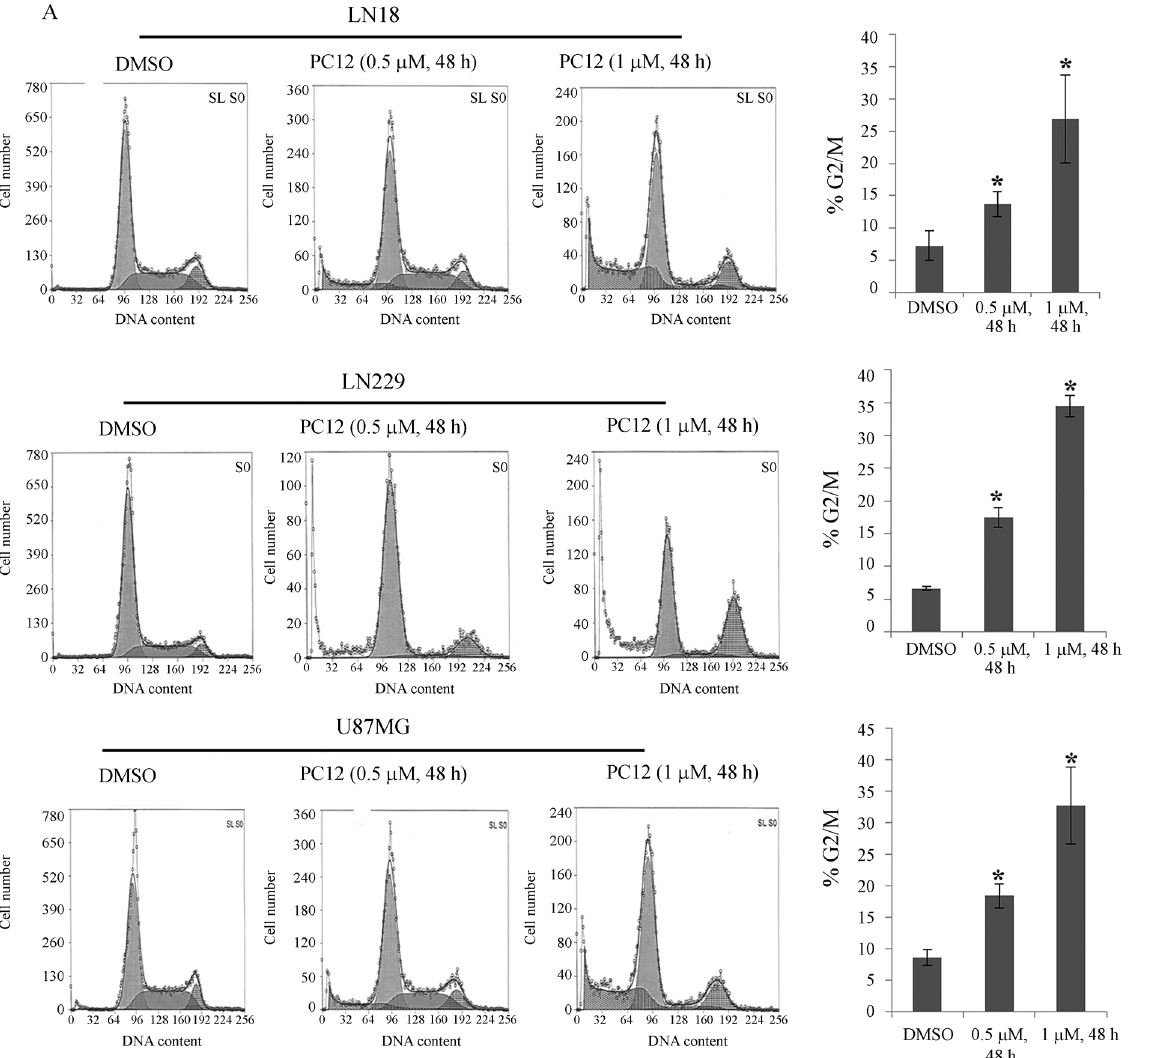
Figure 2 - PCI-24781-induced G2 cell cycle inhibition and apoptosis in malignant glioma cells. Note the concentration-dependent increase in (A) G2/M checkpointactivationand(B)malignantgliomacellapoptosis.(C)PARPandcaspase3cleavagewasdetectedinthreemalignantgliomacelllinestreated with 0.5 or 1 (cid:2) M PCI-24781. In panels (A) and (C) the columns are the mean (cid:5) SD of 3 determinations. *p < 0.05 compared with the DMSO